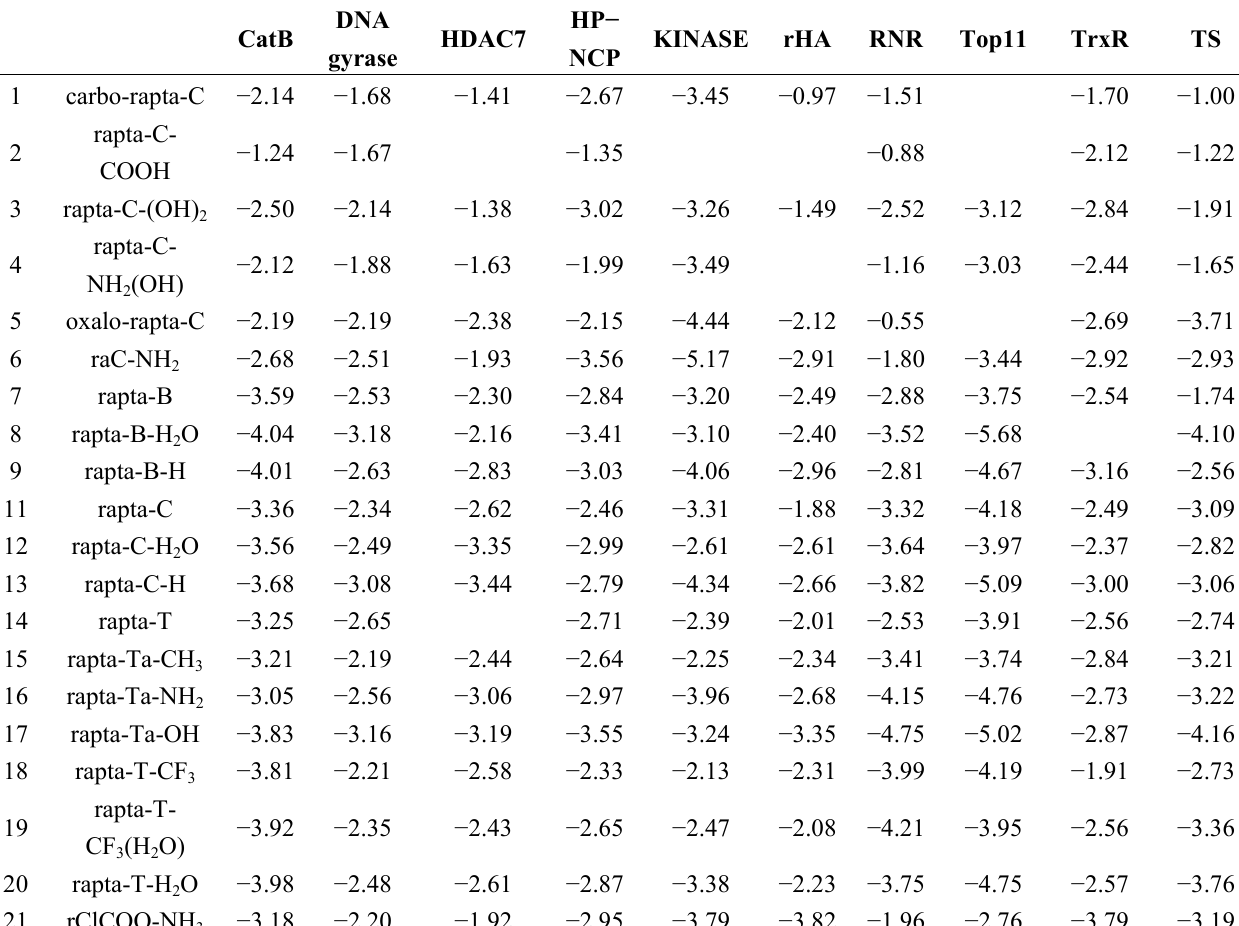
Table 2. The docking result of the metal-based complexes against ten receptors using the Glide package in